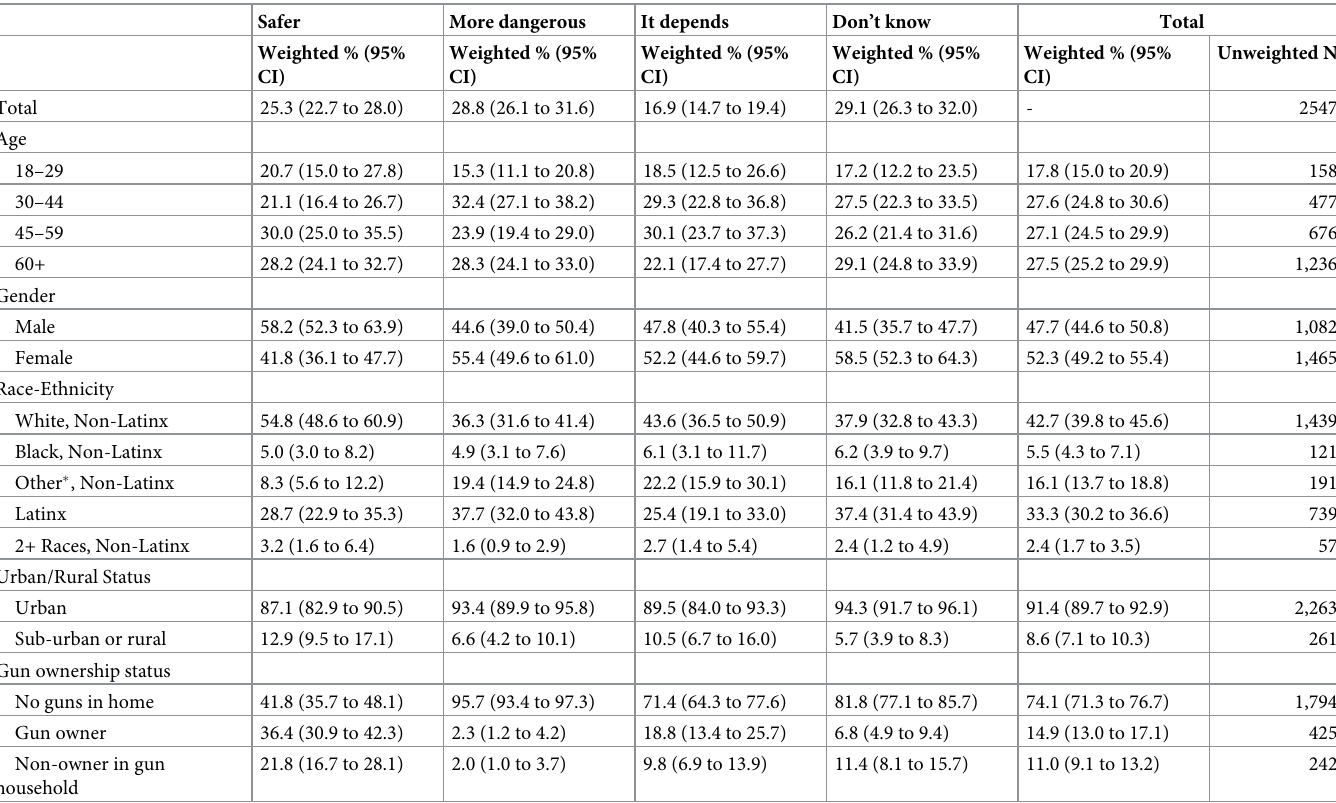
Table 1. (Does/Would) having a gun at your home make it a safer place to be, or a more dangerous place to be?, by demographics and gun ownership